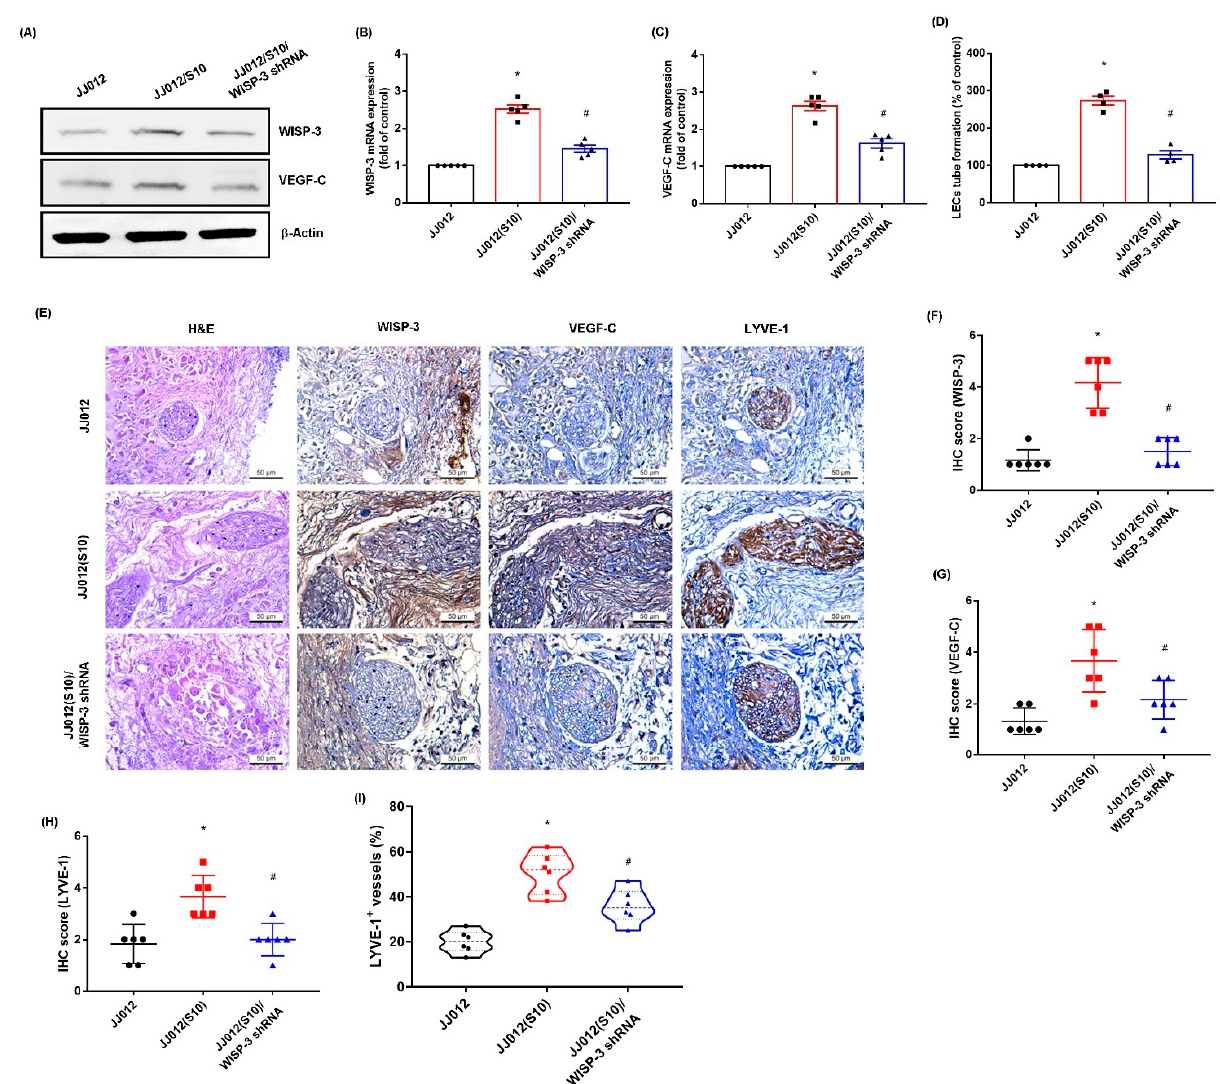
Figure 6. Inhibition of WISP-3 reduces LEC lymphangiogenesis in vivo. ( A – C ) WISP-3 and VEGF-C expression were examined by Western blot and qPCR in the indicated cells. ( D ) CM was collected from the indicated cells then applied to LECs and LEC tube formation was measured. ( E – I ) At 28 days after the mice were injected, the tumors were embedded in paraffin and sections were immuno-stained using WISP-3, VEGF-C, and LYE-1 antibodies. Quantitative results are expressed as the mean ± SD. All experiments were repeated 3 to 6 times (solid squares, solid dots, hollow circles and solid triangles). * p < 0.05 compared with the JJ012 group; # p < 0.05 compared with the JJ012(S10) group.